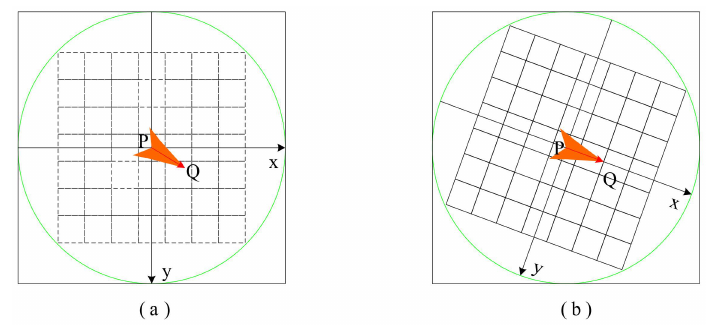
Figure 4. The coordinate system is created when calculating the BRIEF descriptor. ( a ) is the selected point pair, and ( b ) is the matching point pair calculated after